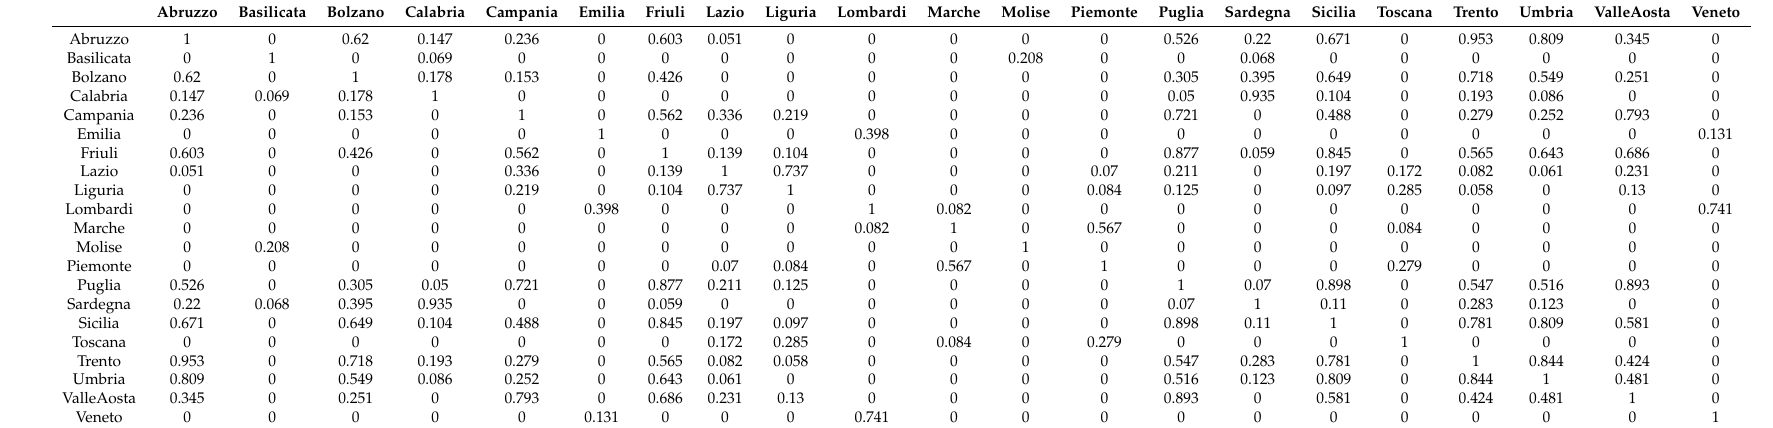
Table A31. Similarity values of New Currently Positive network in the study period.